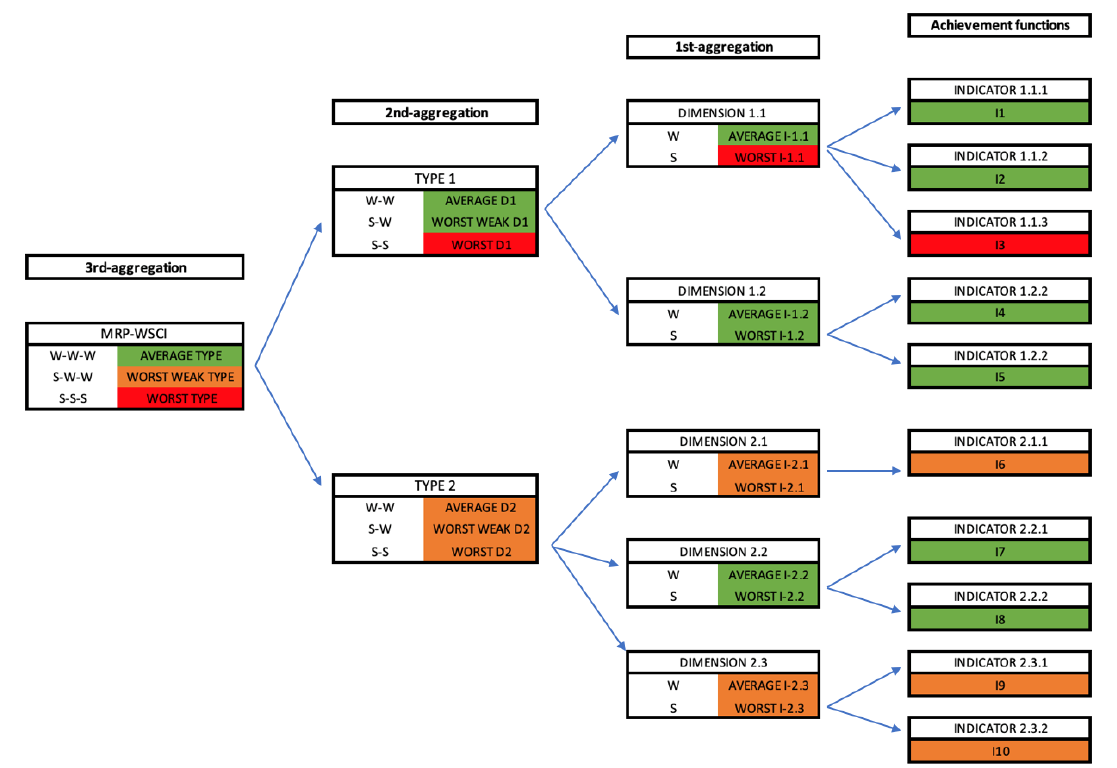
Figure 2. Hypothetical example of the Light-Diagram tool, for a hierarchy of ten criteria, five dimensions and two types. The meaning of each composite indicator is briefly described. Different colors indicate different performance